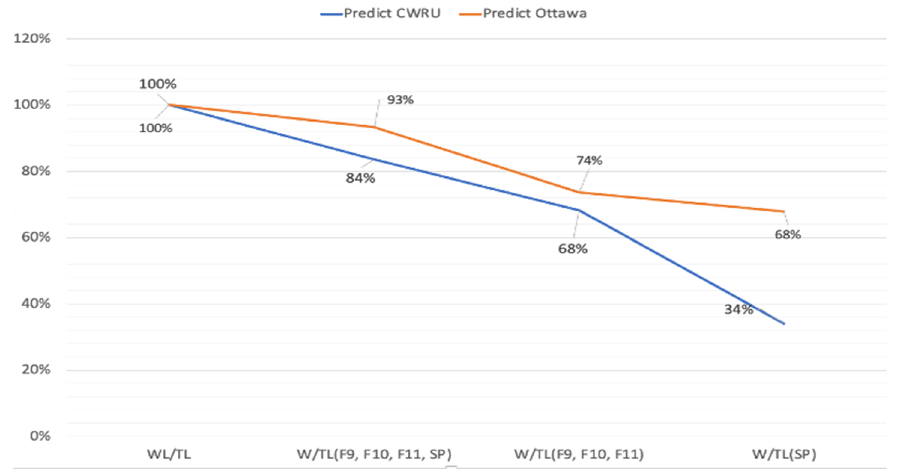
Figure 7. The result of training time reduction using feature transferring from Ottawa to CWRU.